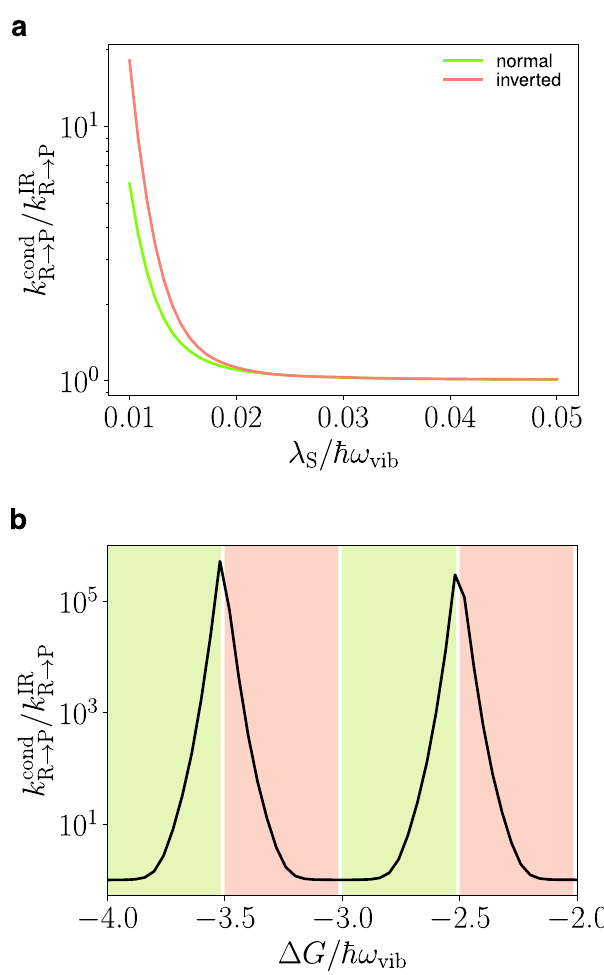
and outside Fig. 6 Rate constant. Ratio of the rate constants inside k cond R ! P k IR of the cavity under laser excitation with Δ = − 0.0695 ω vib , R ! P k B T = 0.1389 ℏ ω vib ( T = 298 K when ℏ ω vib = 185 meV), S = 3.5, ffiffiffiffi p = 0.08 N Γ = 10 7 for symmetric coupling ¼ 0 : 1 ω 2 g N ↓ and N vib , P − g R = g P = g . a Relative rate constant as a function of reorganization energy, λ Δ G = − 3.33 ℏ ω S , with vib (the pink curve; here, the dominant channel lies in the inverted regime) and Δ G = − 3.73 ℏ ω vib (the green curve; here, the dominant channel lies in the normal regime) and b as a function of Δ G with λ = 10 − 2 ℏ ω S vib . Here, the pink region corresponds to the dominant channel in the inverted regime and the green to the normal